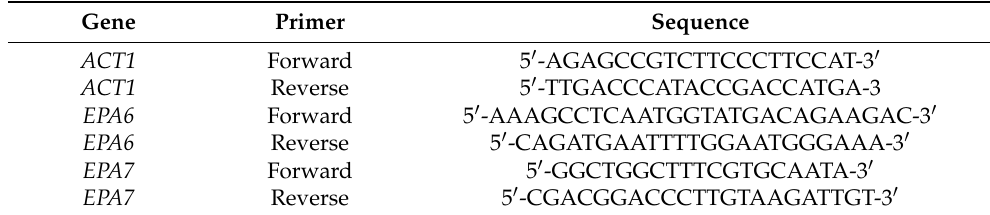
Table 1. List of C. glabrata primers used in real-time